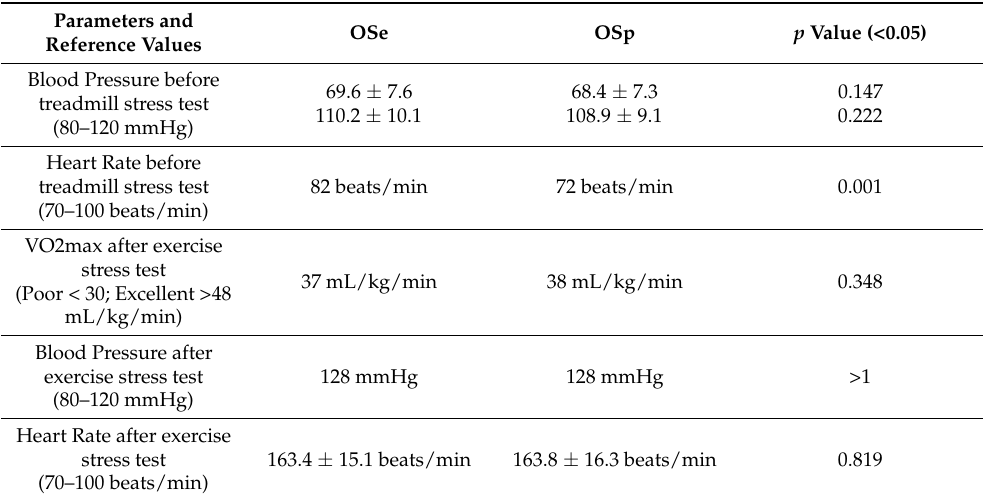
Table 3. Assessment of VO2 max, blood pressure and heart rate in OSe and OSp before and after treadmill stress